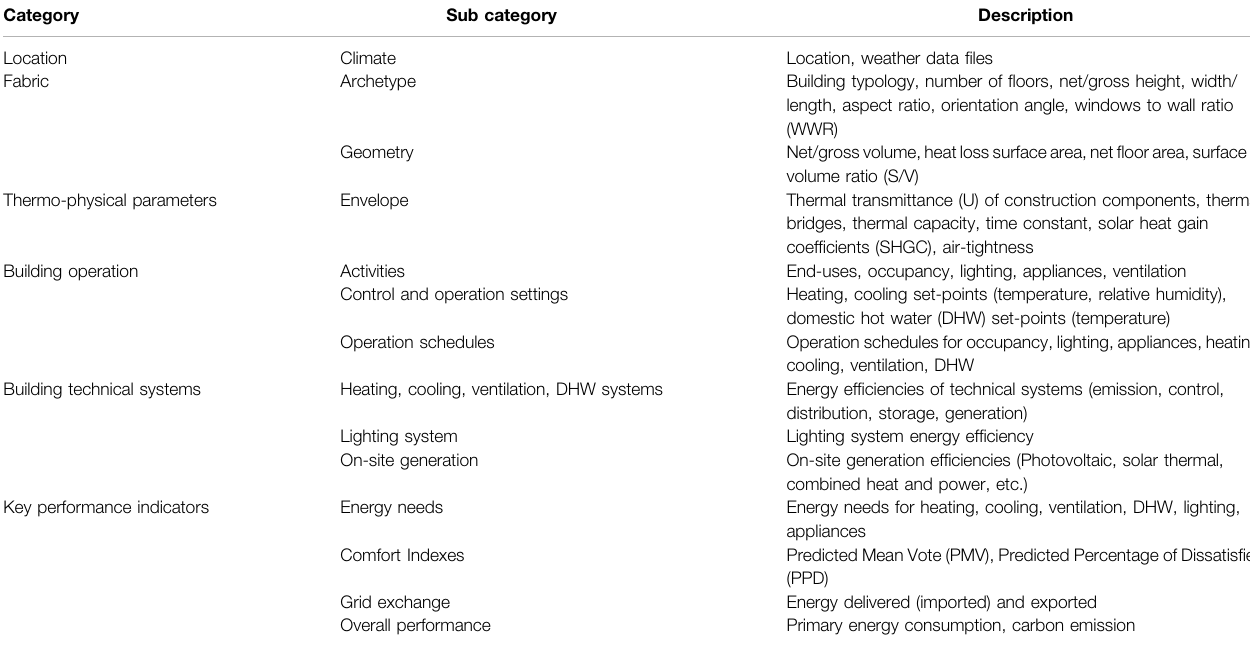
TABLE 1 | Hierarchical structure of building energy modelling